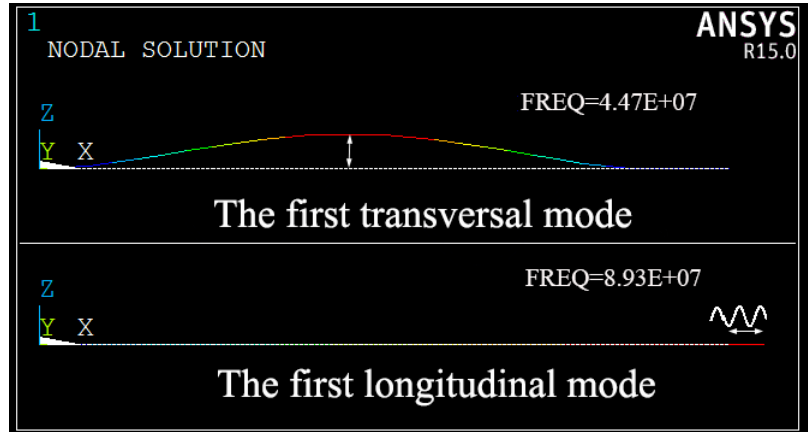
Figure 3. The first transversal mode shape and longitudinal mode